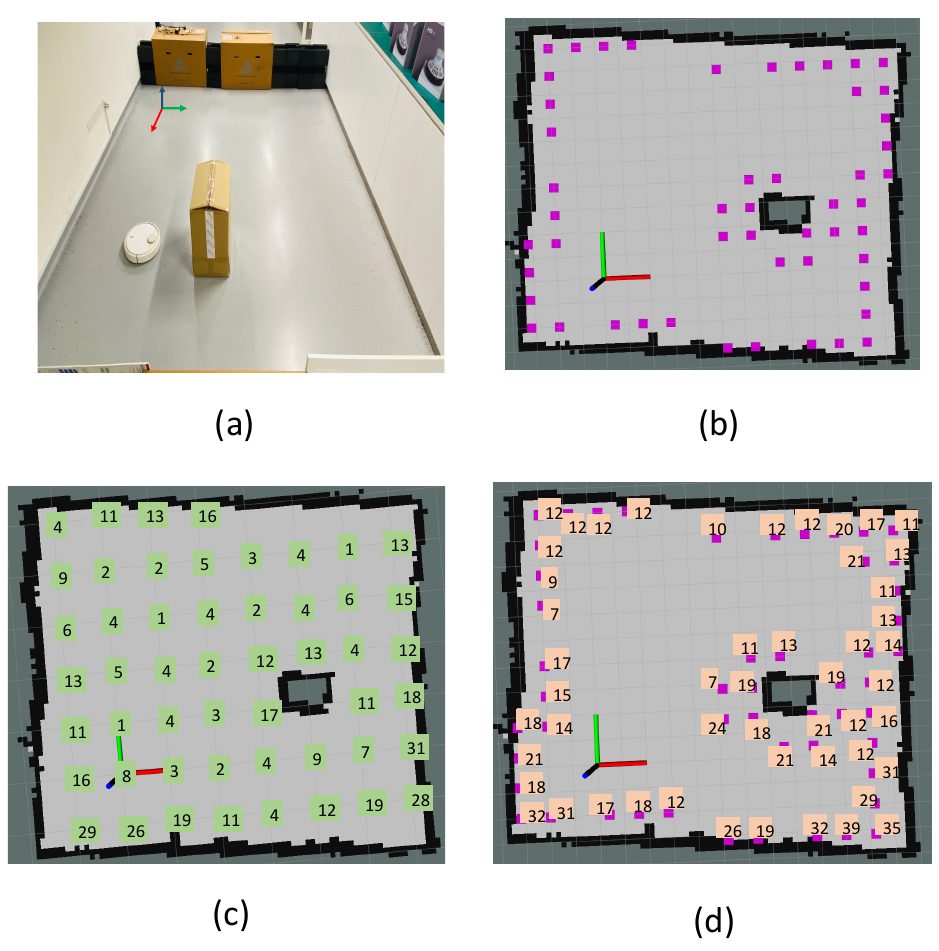
Figure 8. The environment chosen for trial-1.a ( a ), identified sample locations based on the proposed approach ( b ), dirt counts recorded corresponding to locations in a uniform grid sampling ( c ), dirt counts recorded corresponding to identified sample locations based on the proposed approach ( d